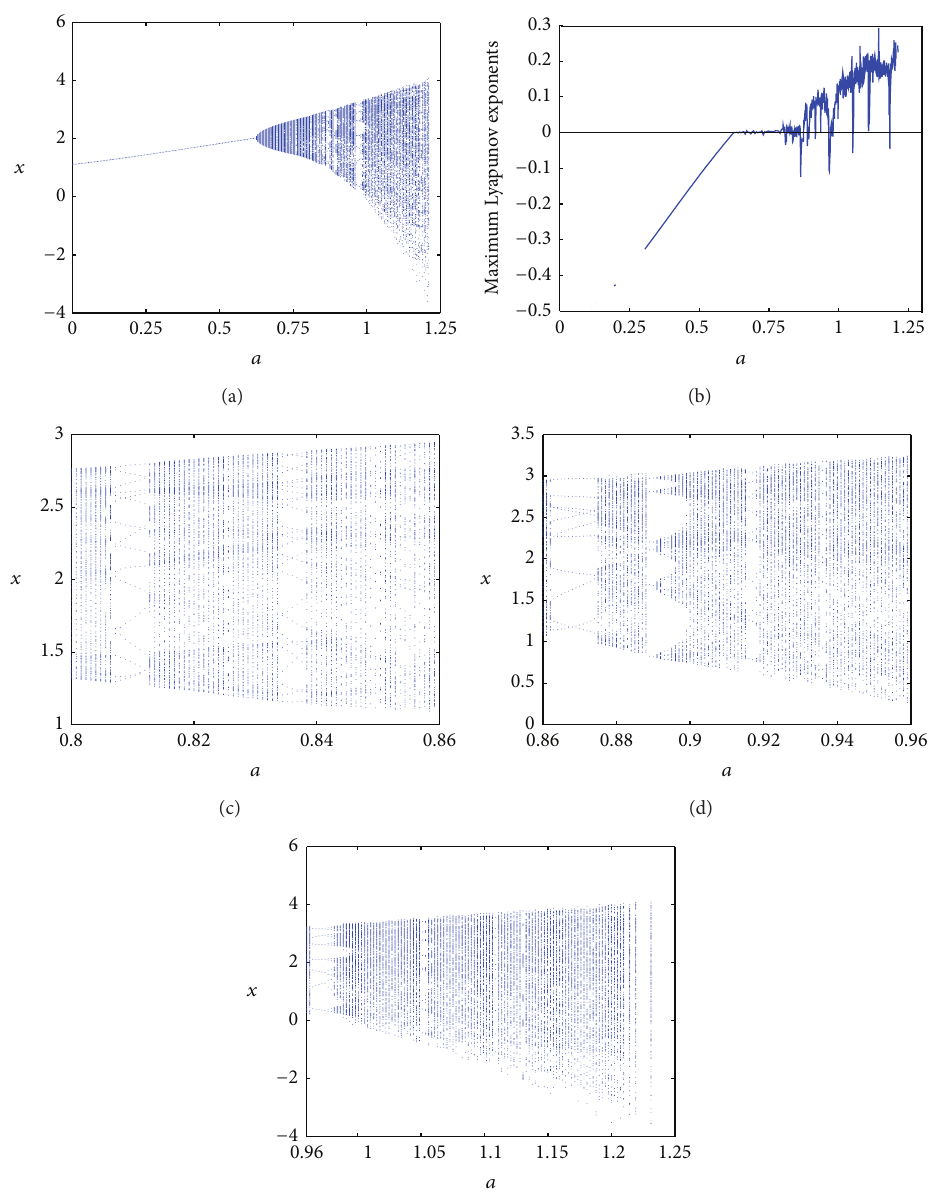
Figure 4: (a) Bifurcation diagram of map (2) in (𝑎,𝑥) plane for 𝑏 = 0.02 , 𝑐 = 0.3 , 𝑑 = −0.15 , and 𝑒 = 0.08 . (b) Maximum Lyapunov exponents corresponding to (a). (c)–(e). Local amplification of (a) for (c) 0.8 ≤ 𝑎 ≤ 0.86 , (d) 0.86 ≤ 𝑎 ≤ 0.96 , and (e) 0.96 ≤ 𝑎 ≤ 1.25 .